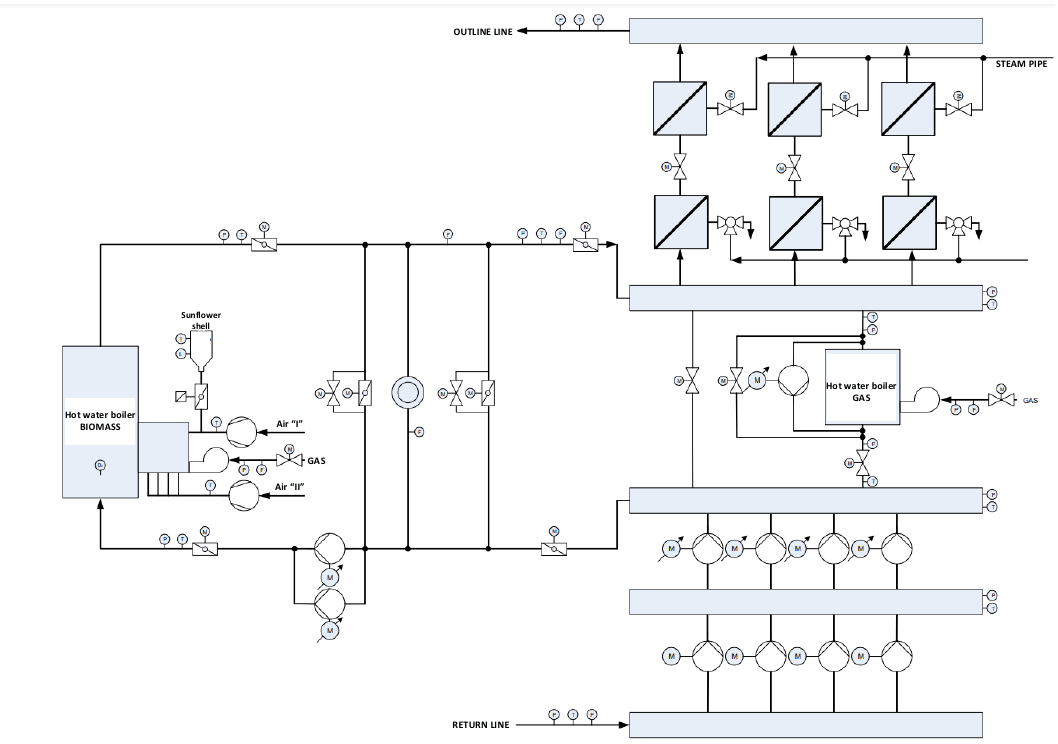
Figure 2. Simplified scheme of the CHP “TE-TO Sremska Mitrovica” (P, pressure; T, temperature; F, flow; L, level; M, electromotor).